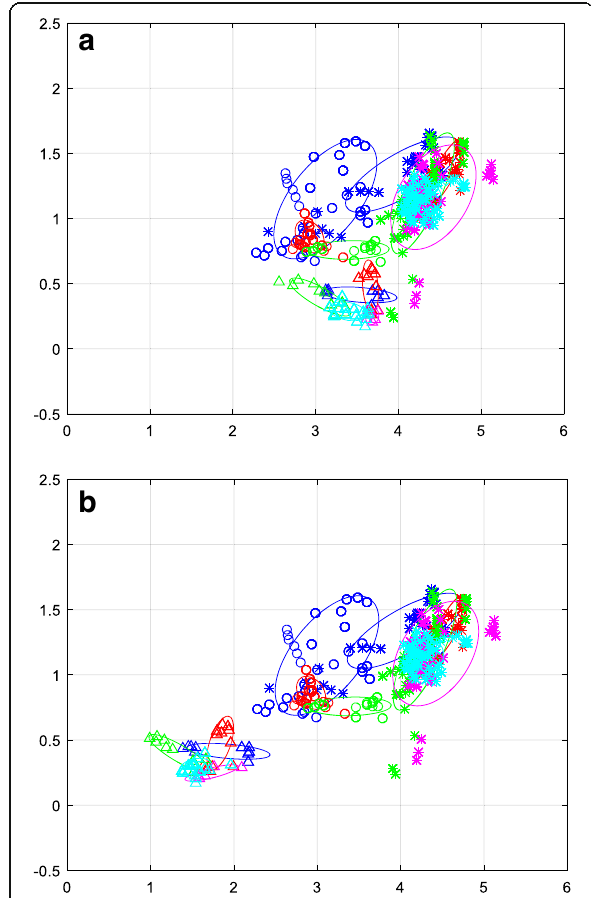
Fig. 18 The figures are plotted in the parameter A - B plane with all the vowels in one repetition for the first subject. a CLNF with corrected B parameter but non corrected A parameter for the round lips. b CLNF with both corrected B and A parameters for the third viseme with automatic detection of the third viseme; stars correspond to the first viseme, circles to the second viseme, and triangles to the third viseme. The color order is blue , red , green , magenta , and cyan . They are corresponding with the vowel order shown in Table